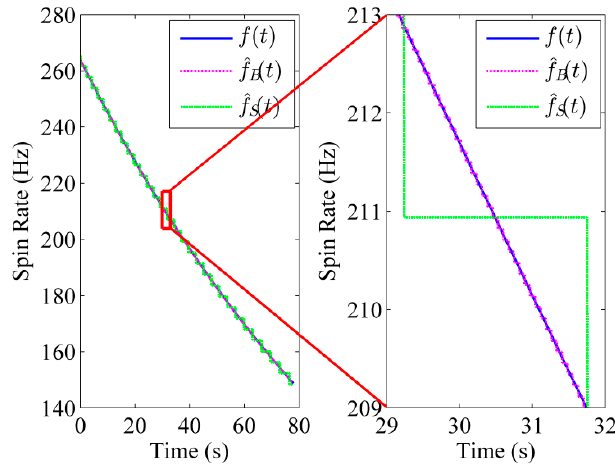
Figure 14. The comparison of theoretical and actual spin rate. The solid blue line, dotted pink line and dashed green line show the theoretical spin rate, actual spin rate extracted by the BCZT and actual spin rate extracted by the STFT, respectively.